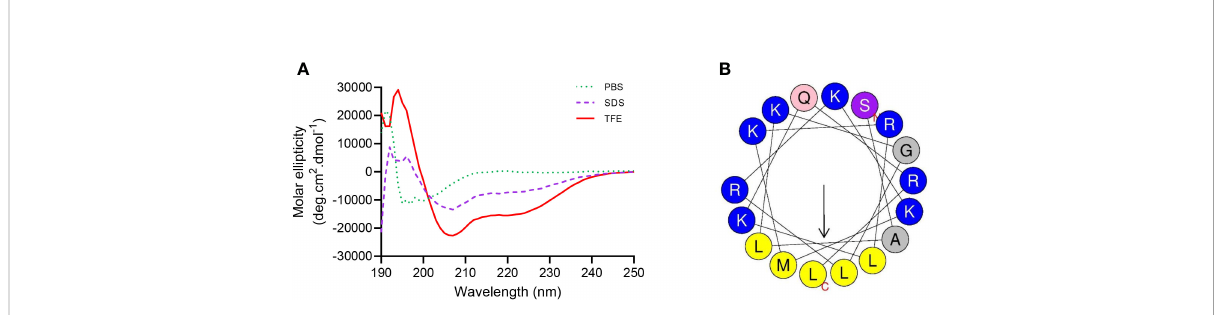
FIGURE 6 Structure analysis of SKL17-2. (A) Circular dichroism spectra of SKL17-2. The data from the three scans were averaged per sample, and the peptide concentration was set at 0.2 mg/mL. (B) Helical wheel projection of SKL17-2. The output of the helical wheel projection shows charged residues as blue, hydrophobicity residues as yellow, uncharged residues as light pink, alanine and glycine as gray, and serine as gray purple by